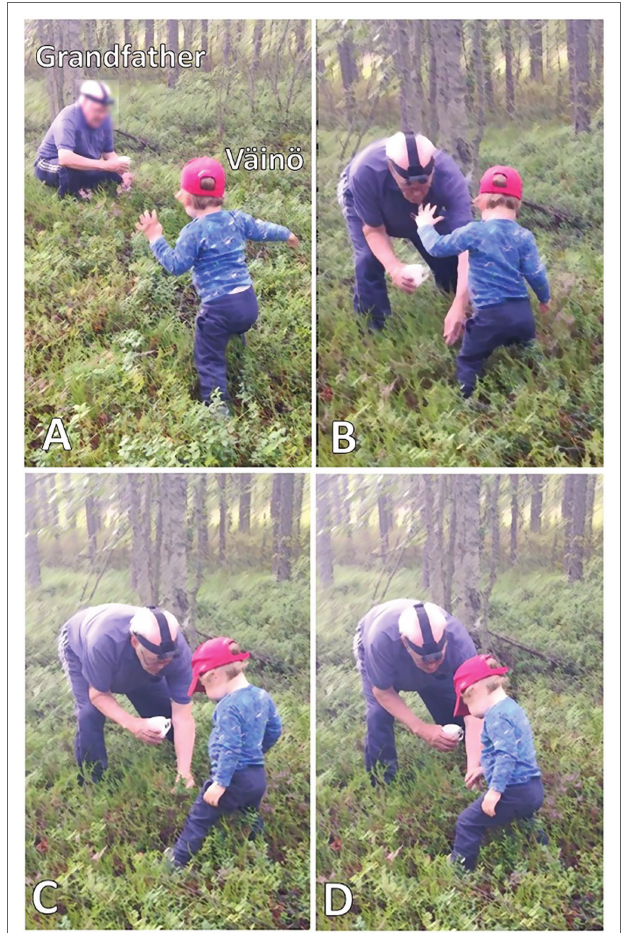
FIGURE 9 | Grandfather picks bilberries and Väinö walks toward him (A) . Grandfather points at a berry in front of Väinö (B) . Grandfather holds berry twig with his left hand (C) . Väinö stretches out his right hand toward the berry (D)